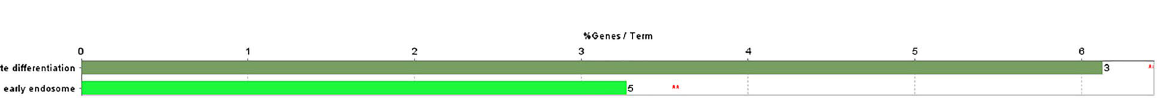
Figure 6. Results for enrichment analysis for target genes of gga-miR-1612: percentage of GOs for Kappa score groups.